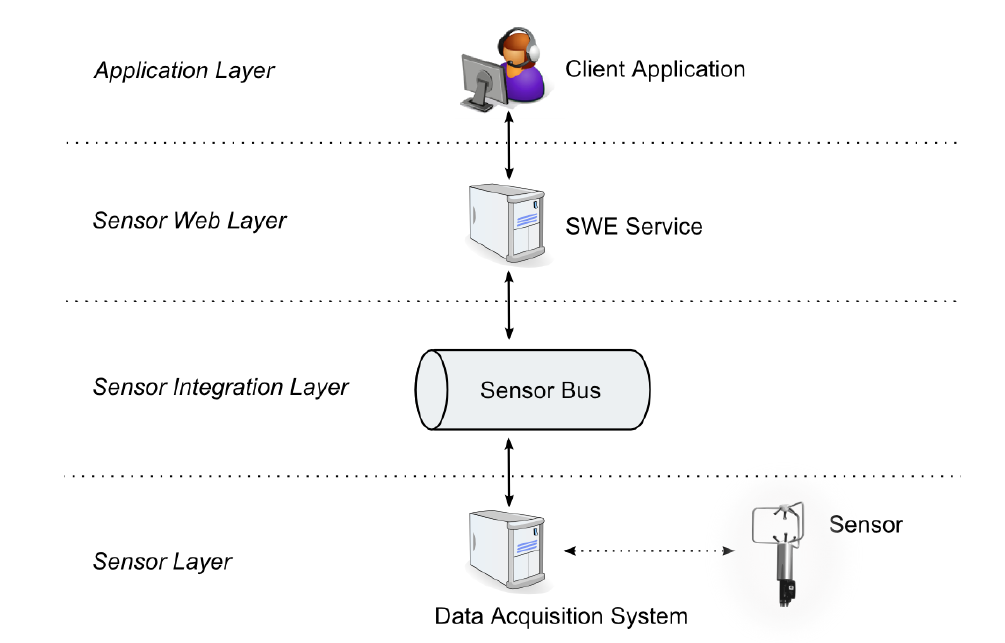
Figure 5. The sensor infrastructure